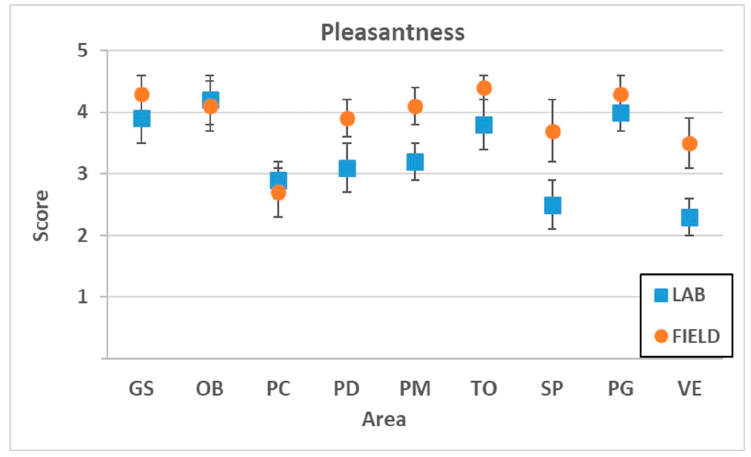
Figure 7. Pleasantness scores in laboratory and in field campaigns.